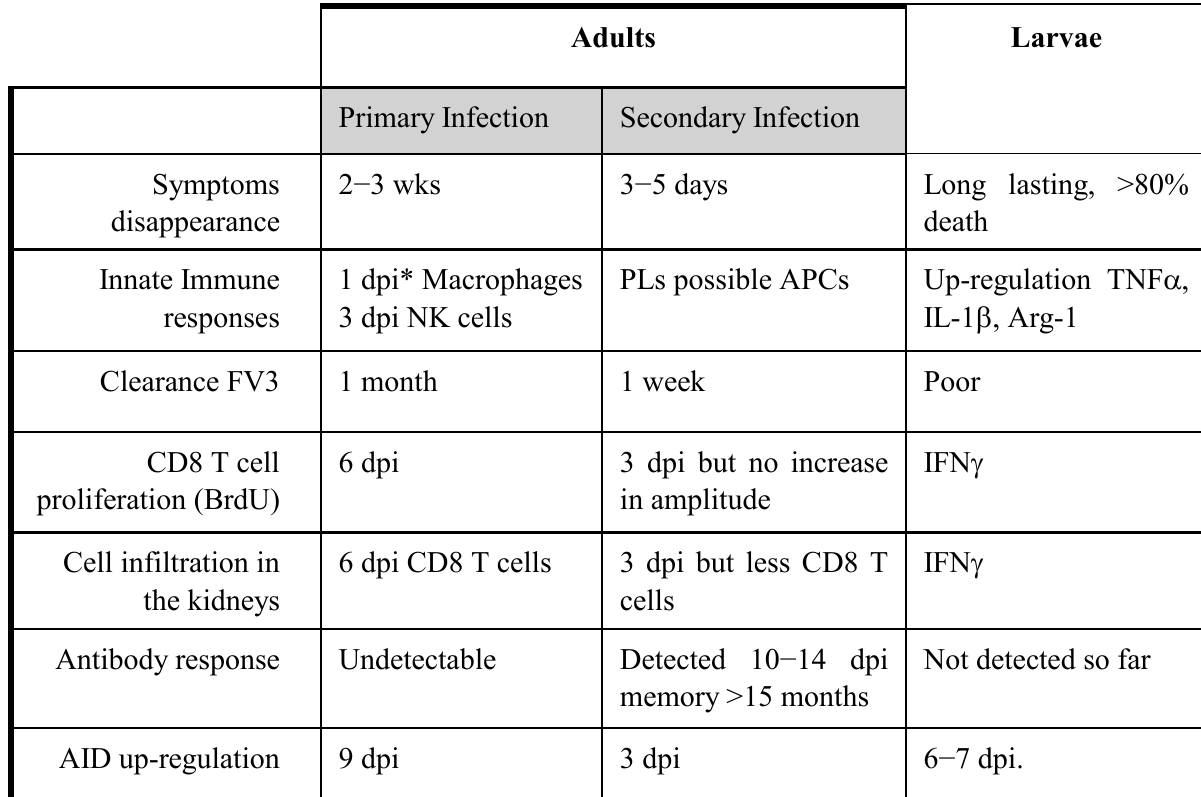
Table 2. Overview of anti-FV3 immune response in X.